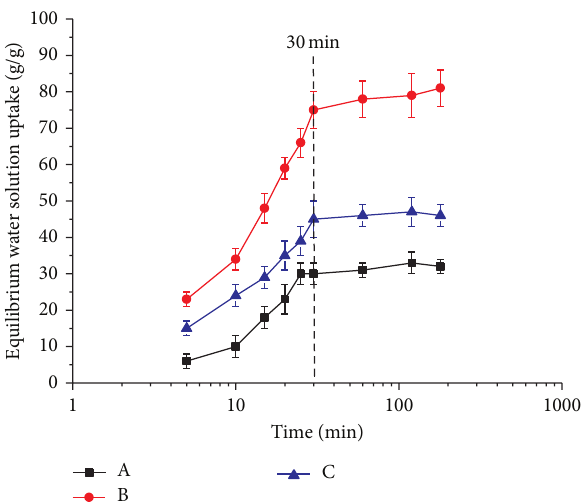
Figure 5: Plot of the equilibrium swelling ratio versus the pH of the external solution bathing the hydrogel ( 𝑛 = 5